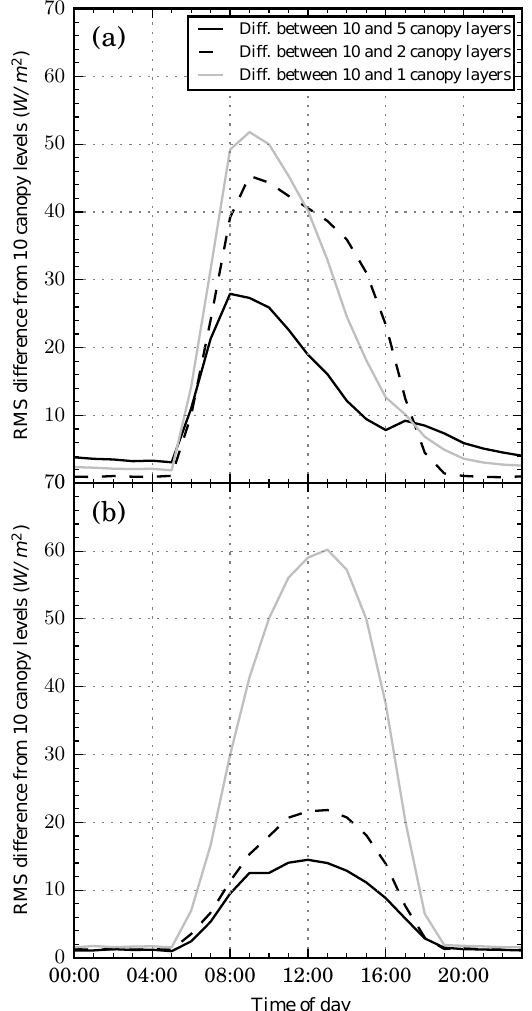
Figure 8. Comparison of model performance for a set-up with 10 canopy layers (out of 30 total profile levels), 5 canopy layers (of 15 total profile levels), 2 canopy levels (of 8 total profile levels), and 1 canopy levels (of 5 total profile levels), expressed as an hourly av- erage for a year-long run. (a) Root mean square difference between the different model runs for sensible heat flux; (b) as (a) for latent